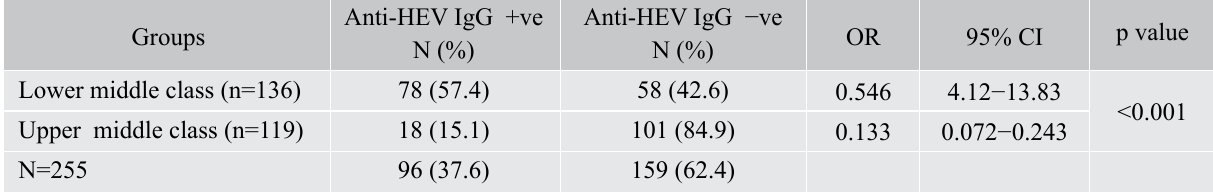
Table II: Odd ratio for HEV IgG seropositivity on the basis of socio-economic classes